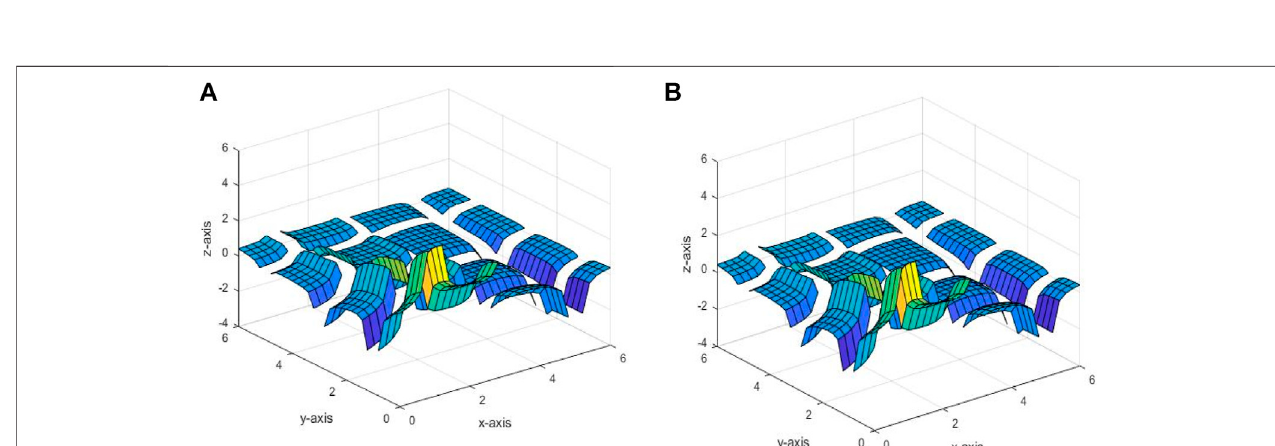
FIGURE 3 | Poles on the surface. (A) α i , j (cid:2) β i , j (cid:2) (cid:4) α i , j (cid:2) (cid:4) β i , j (cid:2) − 1 . (B) c i , j (cid:2) (cid:4) c i , j (cid:2) − 2 .